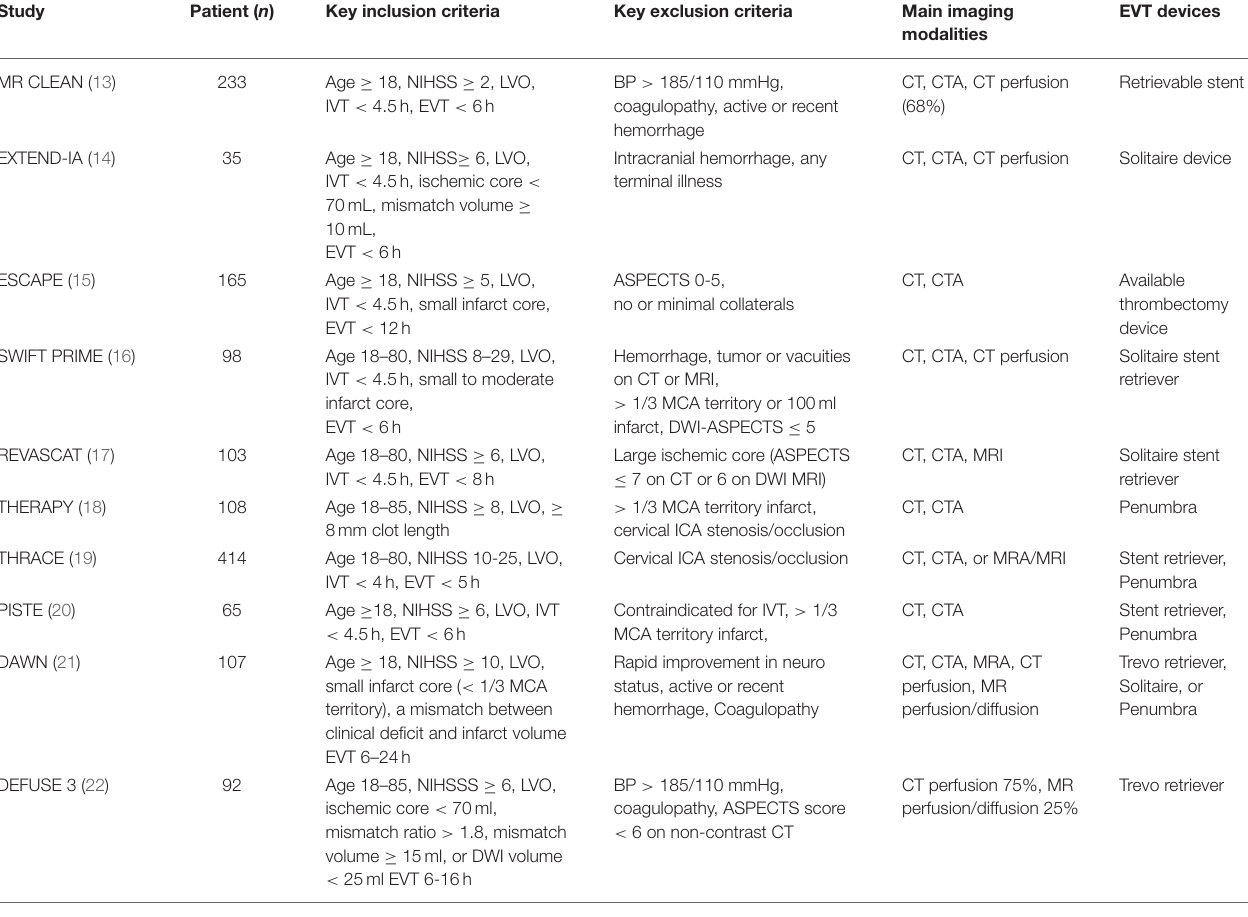
TABLE 1 | Landmark studies of EVT for AIS from LVO in the anterior circulation. Study